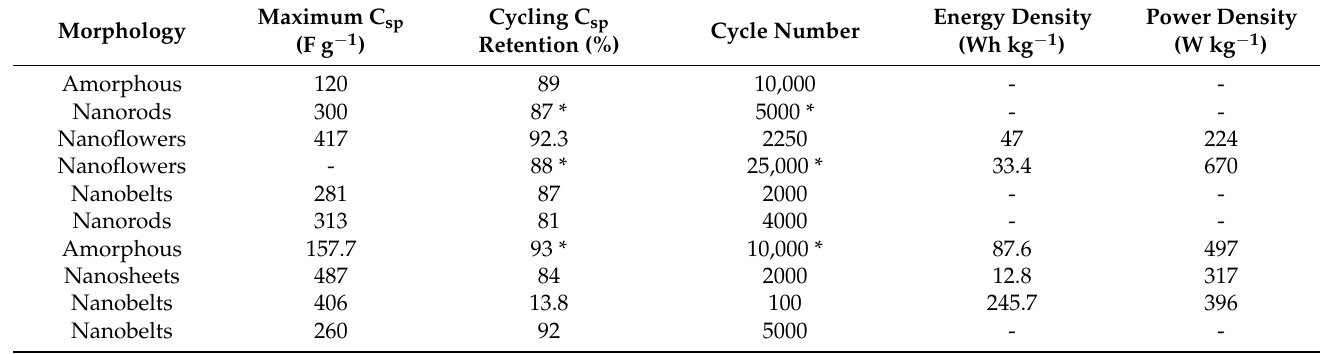
Table 4. V 2 O 5 morphology and electrochemical performances of other V 2 O 5 /carbon composite electrodes for supercapacitor